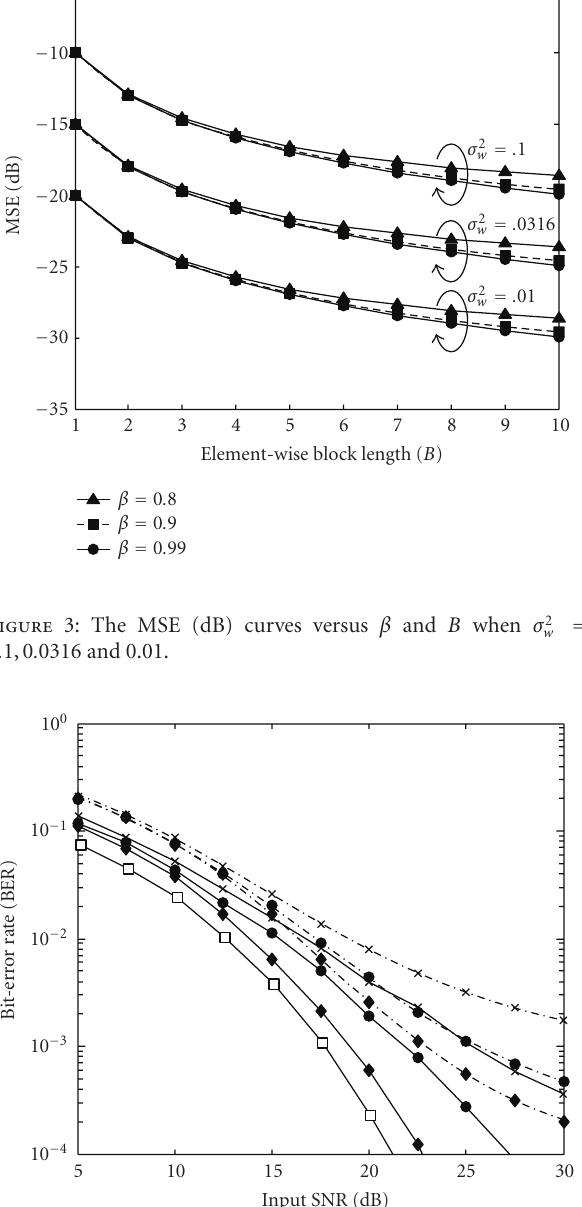
interleaver [8]. One block consists of 64 symbols ( N = 64), where the symbol duration is T s = 3 . 69 μ s. A normalized root mean square (rms) delay spread τ = 0 . 2886 and radio channel memory of 3 (sample delay) are assumed for the TU channel as in Jake’s model [7]. The CP length of 3 was set to eliminate the IBI. A data frame consists of 16 data blocks and